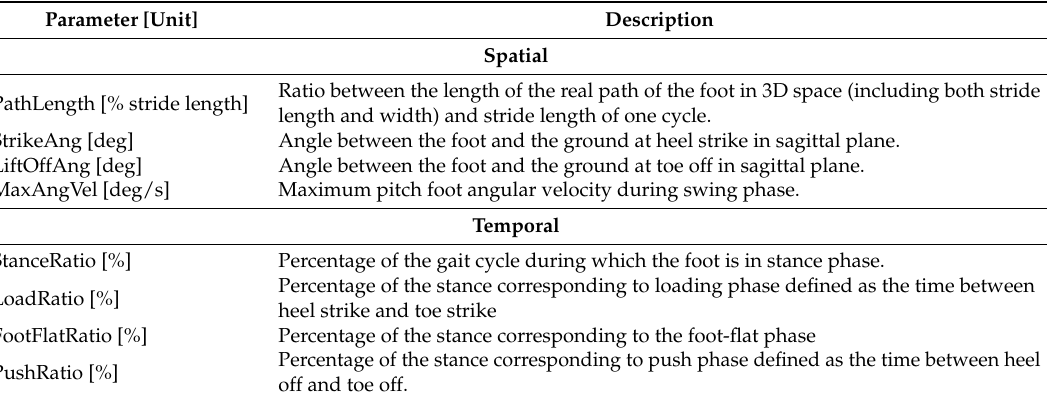
Table 1. Spatiotemporal parameters analyzed for each foot in one gait cycle. Parameter [Unit]